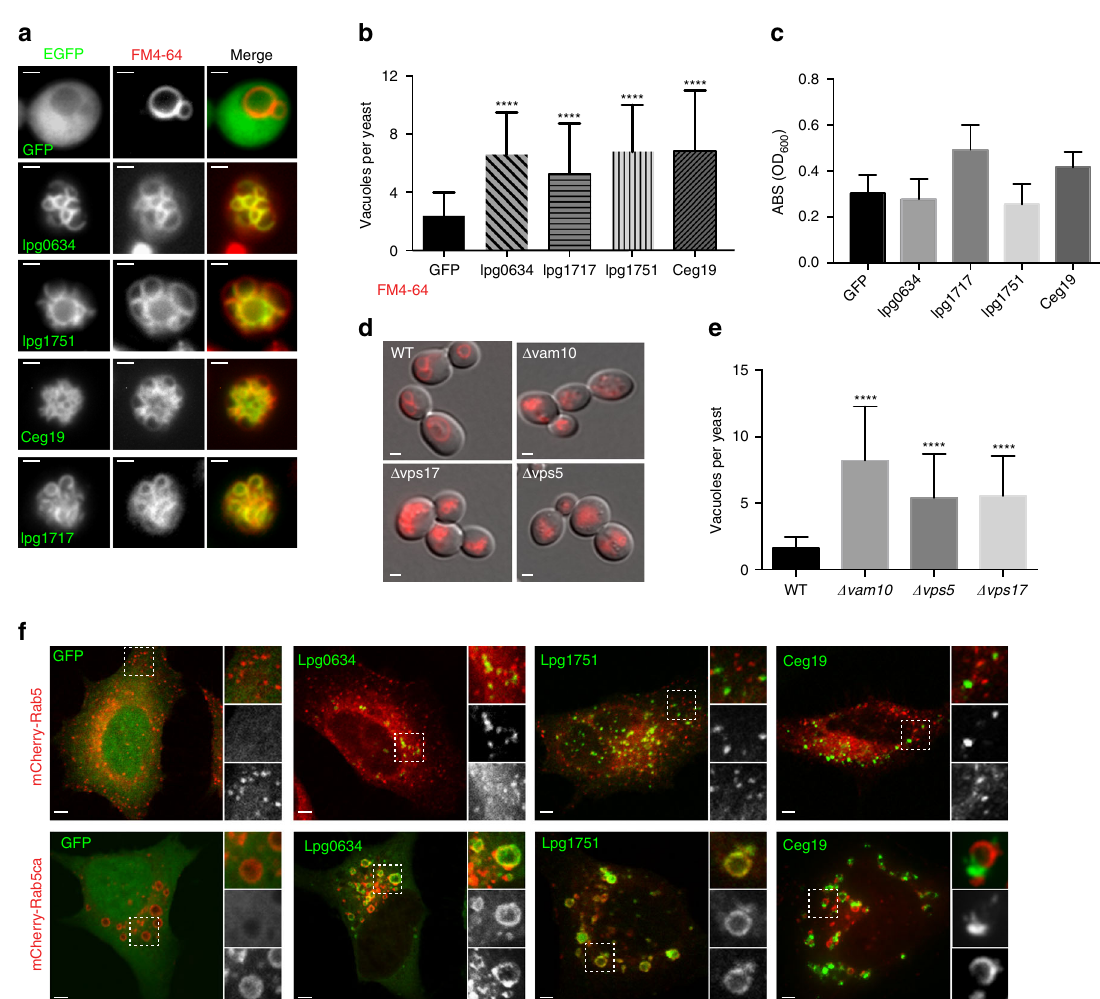
Fig. 4 Legionella effector proteins target endocytic compartments in eukaryotic cells. a Fm4-64 dye ( red ) labeled vacuoles in S. cerevisiae expressing the Legionella effectors, GFP-Lpg0634, GFP-Lpg1717, GFP-Lpg1751, GFP-Ceg19, or GFP control. Scale bar is 1 µ m. b Average number of vacuoles per yeast cell expressing either EGFP, the Legionella effectors (Lpg0634, Lpg1717, Lpg1751, or Ceg19). The data are displayed as mean ± SD for the indicated number of yeast cells from three independent experiments. Average number of vacuoles per wild-type yeast cells is between 1 and 3. Dunnett ’ s multiple comparisons test used for statistical analysis (95% CI, **** p < 0.0001). c Growth assay of yeast expressing EGFP or EGFP-tagged Legionella effectors from ( a ) after 72 h induction ( d ) FM4-64 labeled vacuoles in yeast strains with speci fi ed Class B vacuole fragmentation gene deleted. Scale bar is 1 µ m. e Average number of vacuoles per yeast cell seen in WT or indicated mutants. The data are displayed as mean ± SD for the indicated number of yeast cells from three independent experiments. Dunnett ’ s multiple comparisons test used for statistical analysis (95% CI, **** p < 0.0001). f Fluorescence microscopy of HeLa cells co-transfected with the Legionella effector indicated ( green ) and either wild-type Rab5 or constitutively active Rab5 ( red ). The boxed region is magni fi ed × 2 and the top is the merge, the middle the GFP signal, and the bottom the mCherry signal. Scale bar is 5 µ